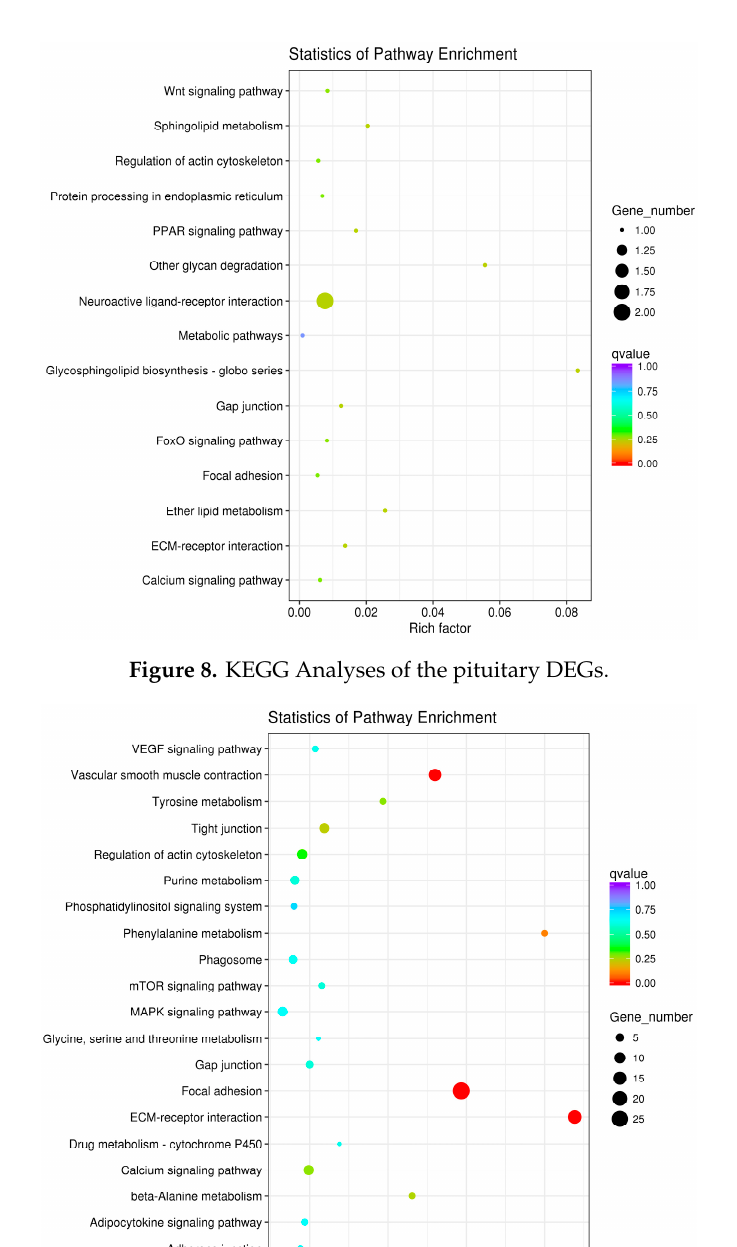
Figure 7. KEGG (Kyoto Encyclopedia of Genes and Genomes) Analyses of the hypothalamic DEGs. The vertical axis represents the pathway name, the horizontal axis represents rich factor, the size of the point represents the number of differentially expressed genes in this pathway, and the color of the point corresponds to different Q-value ranges (the same below).